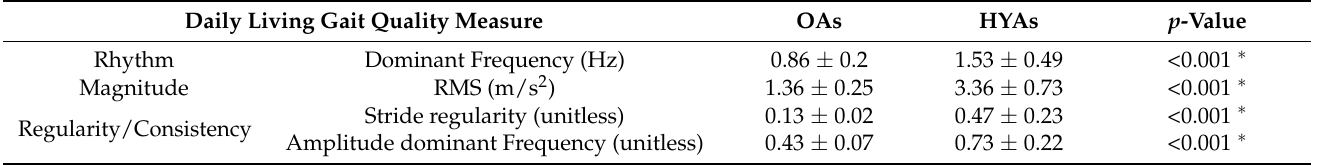
Table 5. Daily living gait quality measures in OAs and healthy adults